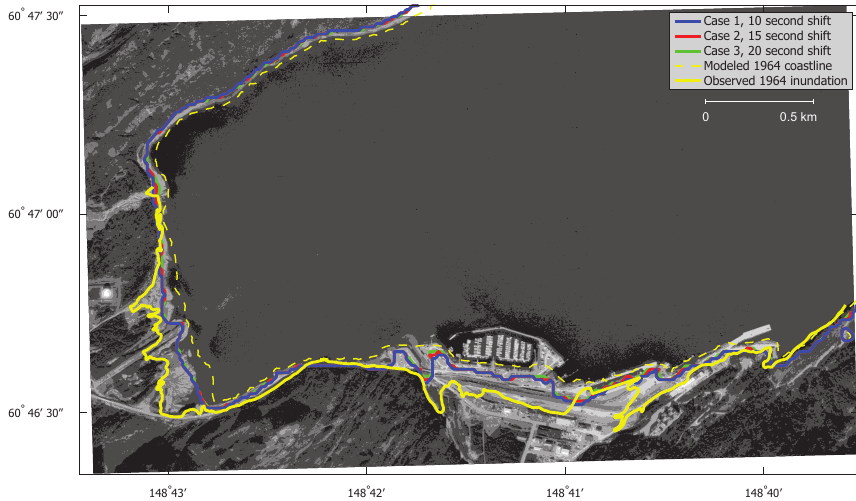
Fig. 9. Maximum computed runup by seiche waves in Passage Canal during the 1964 event. The yellow line represents the observed inundation after the 1964 tsunami. The modeled MLLW shoreline before the earthquake is shown by a dashed yellow line.